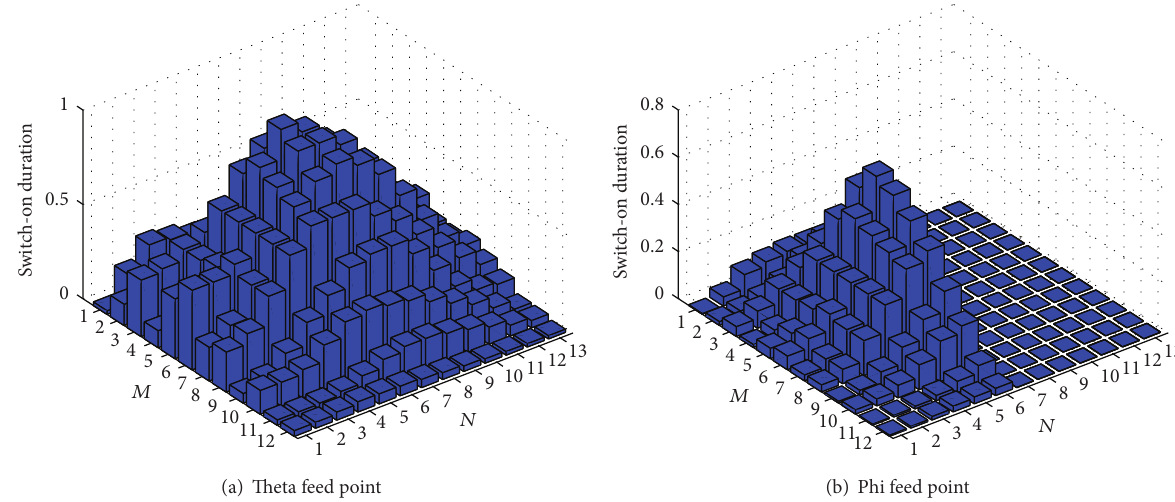
Figure 11: Optimized switch-on durations in the theta feed point and phi feed point for scan direction of (74 ∘ ,0 ∘ ) for solution A in Figure 7.